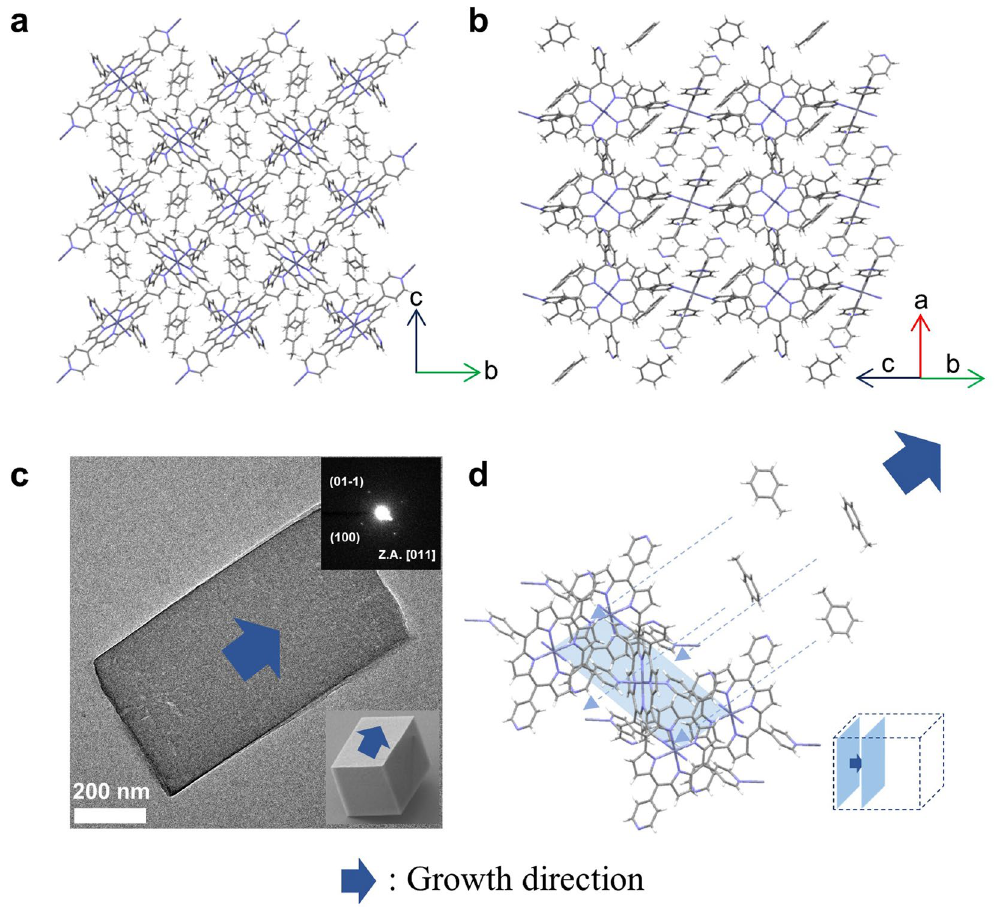
Figure 3. Single crystal structure and TEM analysis of ZnTPyP cube crystal. (a , b ) Single crystal space-filling representations of (100) and (011) plane of cube crystal, respectively. (100) plane shows 2D coordination polymer of ZnTPyP including zinc metal-N axial coordination bonding, and (011) plane shows intercalation of toluene into the 2D coordination polymer. ( c ) TEM image and (inset) selected area electron diffraction (SAED) pattern of square pillar shaped-ZnTPyP corresponding to the TEM image. The arrow represents the growth direction of the ZnTPyP cube, and the zone axis is identified as (011). ( d ) Representation of growth direction introduced by toluene solvent molecule into 2D ZnTPyP coordination